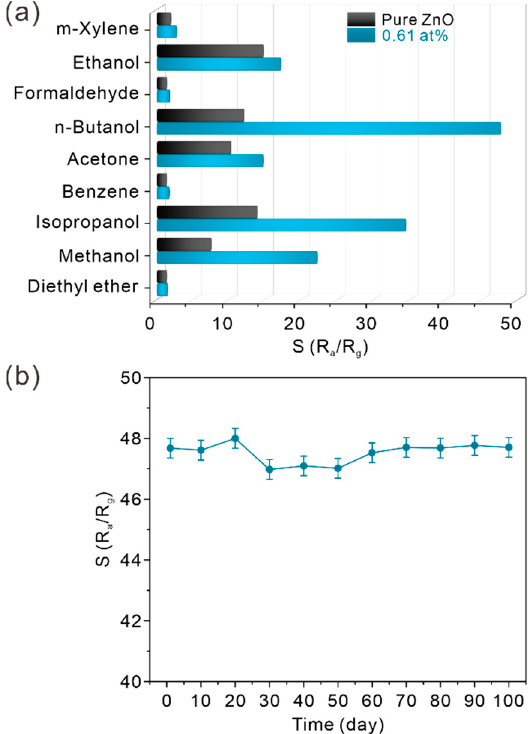
Figure 7. ( a ) The relative responses of pure ZnO porous nanobelts and 0.61 at% Pb-doped ZnO porous nanobelts toward 50 ppm of different VOCs at 300 °C, ( b ) the stability of 0.61 at% Pb-doped ZnO porous nanobelts to 50 ppm n-butanol during 100 days with variance. ZnO porous nanobelts to 50 ppm n-butanol during 100 days with